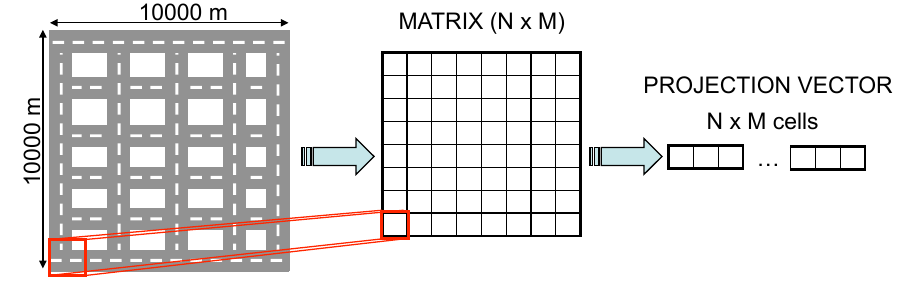
Figure 8. Matching process to obtain a projection